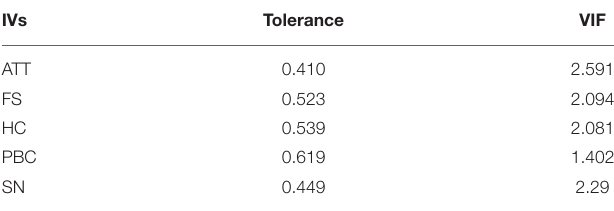
TABLE 4 | Collinearity